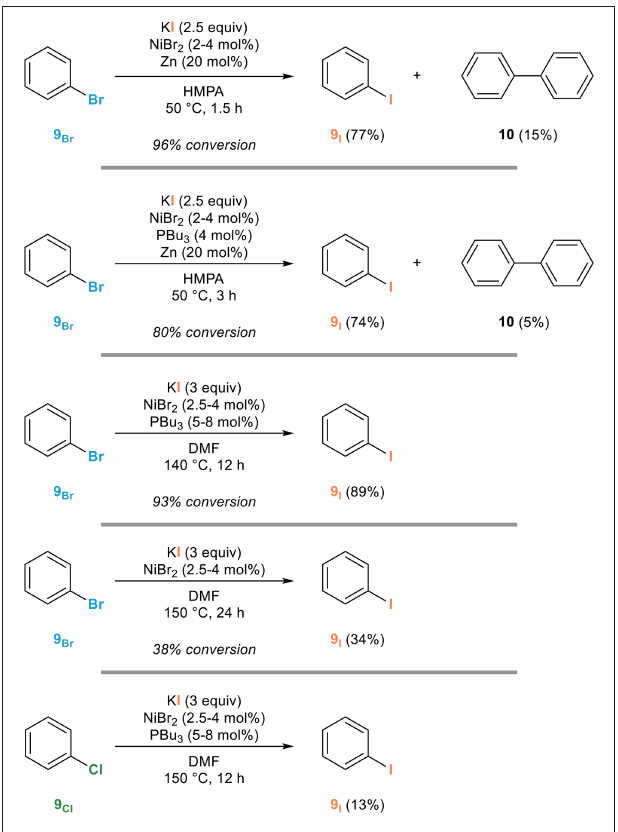
FIGURE 3 | Influence of additives in the nickel-catalyzed aromatic Finkelstein reaction.